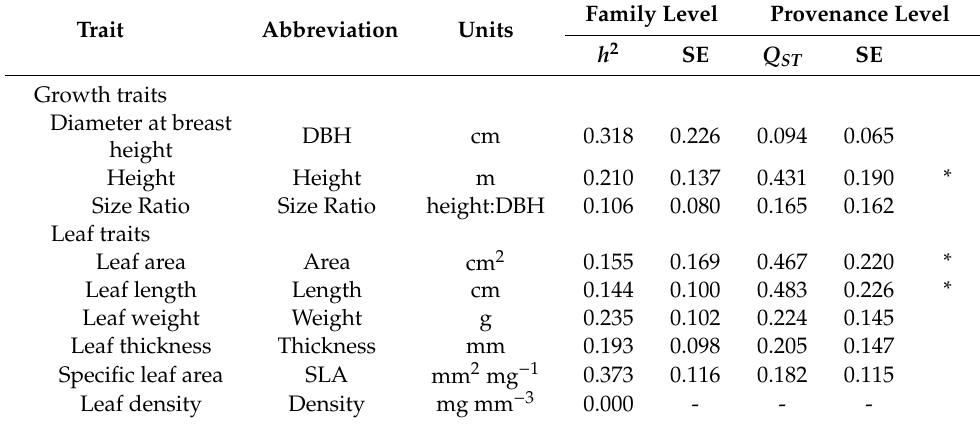
Table 2. Heritability ( h 2 ) and between provenance di ff erentiation ( Q ST ) for nine quantitative traits measured in Eucalyptus microcarpa (Grey box). SE = one standard error.